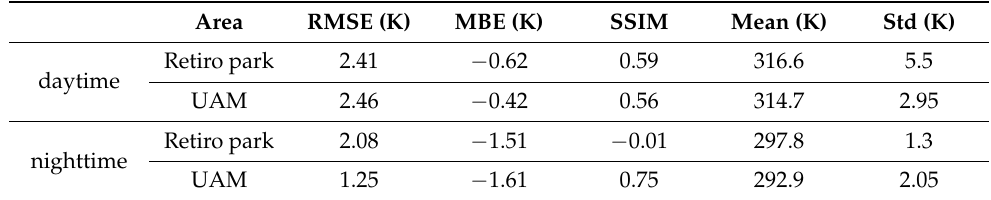
Table 11. RMSE, MBE and SSIM between the the 60-m LST from the 2MMD-4-band TES and the 60-m aggregated LST from the 2MMD-4-band TES and 1st-order statistics of the former.